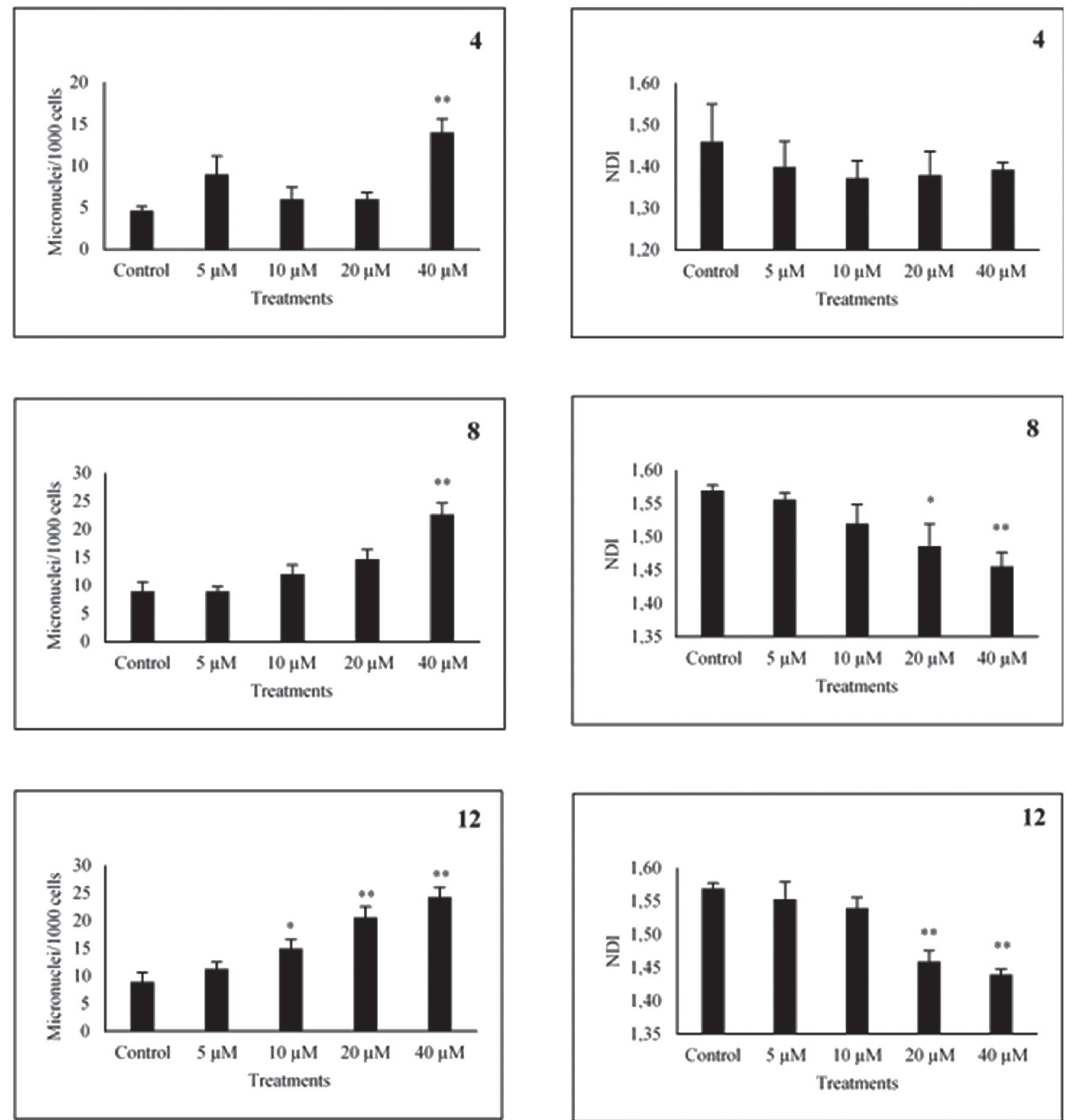
FIGURE 7 - Mean and standard deviation of the frequency of micronuclei in binucleated cells and nuclear division index (NDI) after the treatment of RKO-AS45-1 human cell line with the compounds 4 , 8 and 12 (incubation time = 3 hours). Three independent experiments were performed to each compound. *p<0.05 and **p<0.01 when compared with the control. MMS = Methyl methanesulfonate (400 µM). TABLE II – In vitro effect of 4 , 8 and 12 against S. mansoni somules and the least concentration necessary to